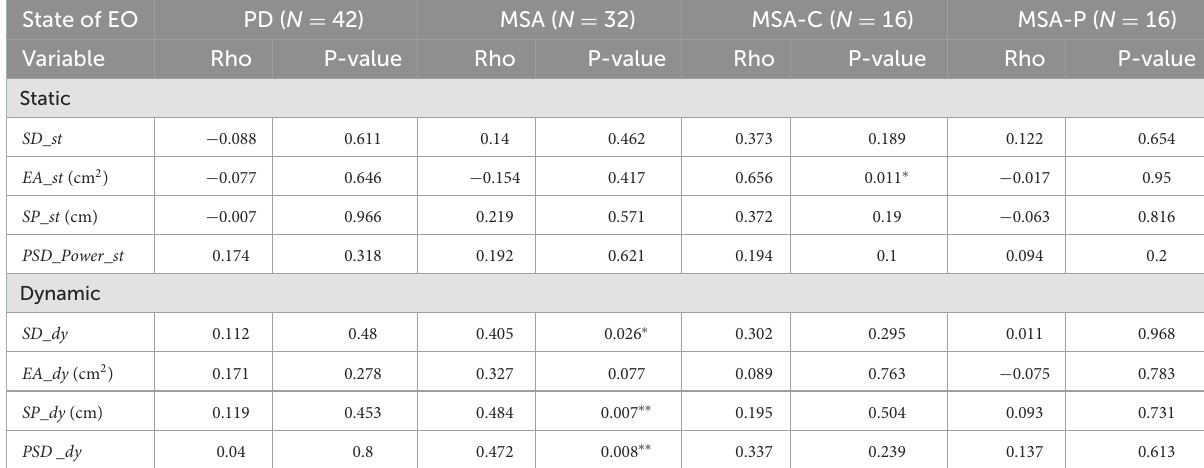
TABLE 5 Spearman’s rank correlation (rho) between subjects’ posturographic variables and H&Y scale score. State of